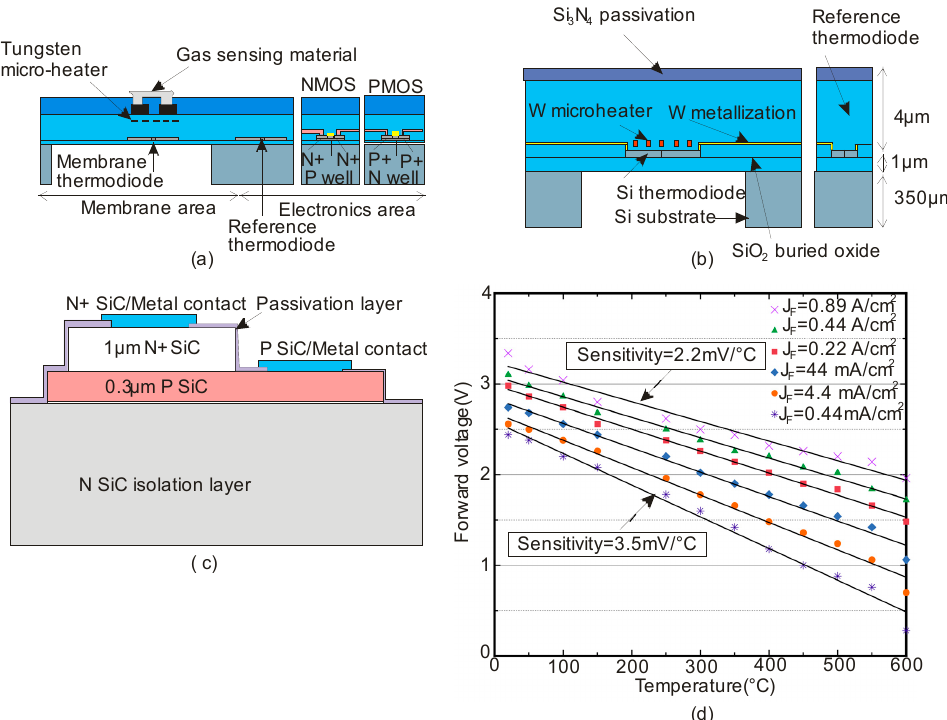
Figure 11 . Examples of recently reported thermoelectronic sensors, ( a ) Cross-sectional view of membrane diodes, reference diode and CMOS cells; ( b ) Cross-sectional view of the micro-heater, suspended diodes and reference diode; ( c ) Cross-sectional view of 4H-SiCpn diode based temperature sensor; ( d ) Measured forward voltage versus temperature at different forward current densities of the 4H-SiC pn diode (reprinted with permission from Appl. Phys. Lett. ).